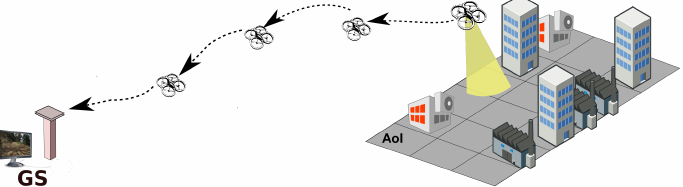
Figure 1. Single-source aerial stream to a ground sink using UAV relays to transmit